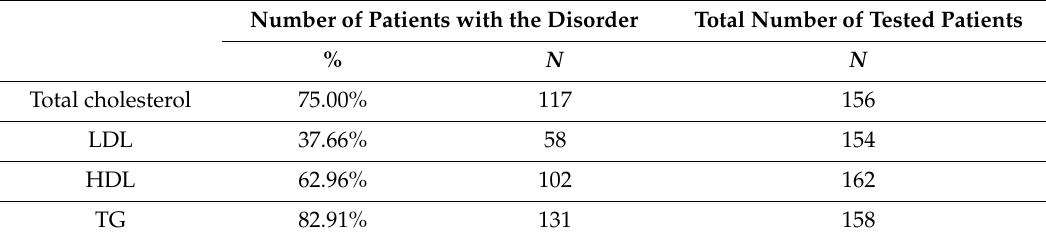
Table 2. Frequency of developing lipid disorders after hematopoietic stem cell transplantation (HSCT) in the analyzed group of